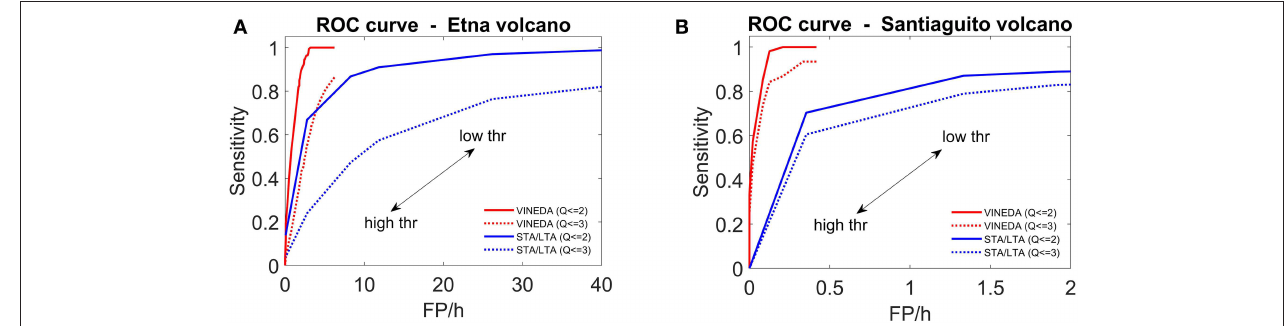
FIGURE 5 | ROC curve for ETNA (A) and Santiaguito (B) volcanoes comparing VINEDA and STA/LTA algorithms for different quality assessments of the experts (thr = thresholds).